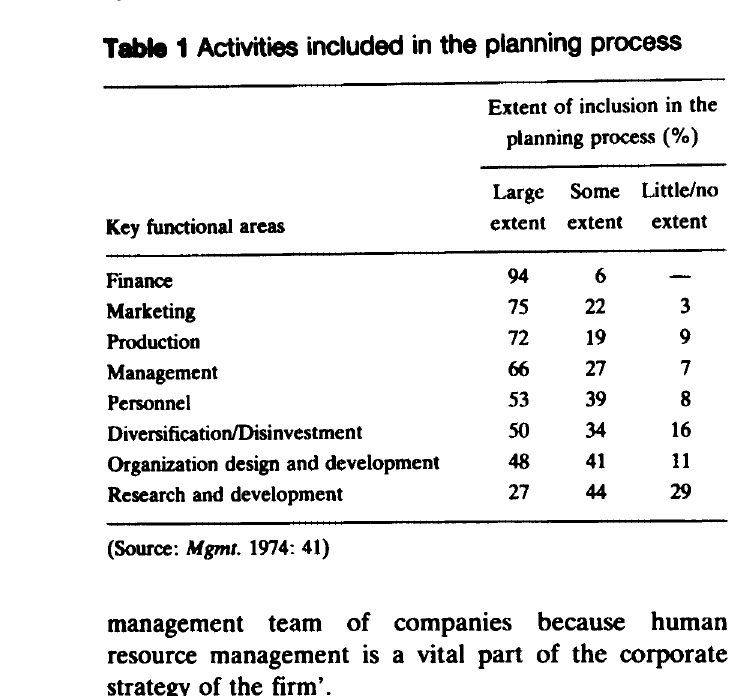
Table 1 ActiVities included in the planning process Extent of inclusion in the